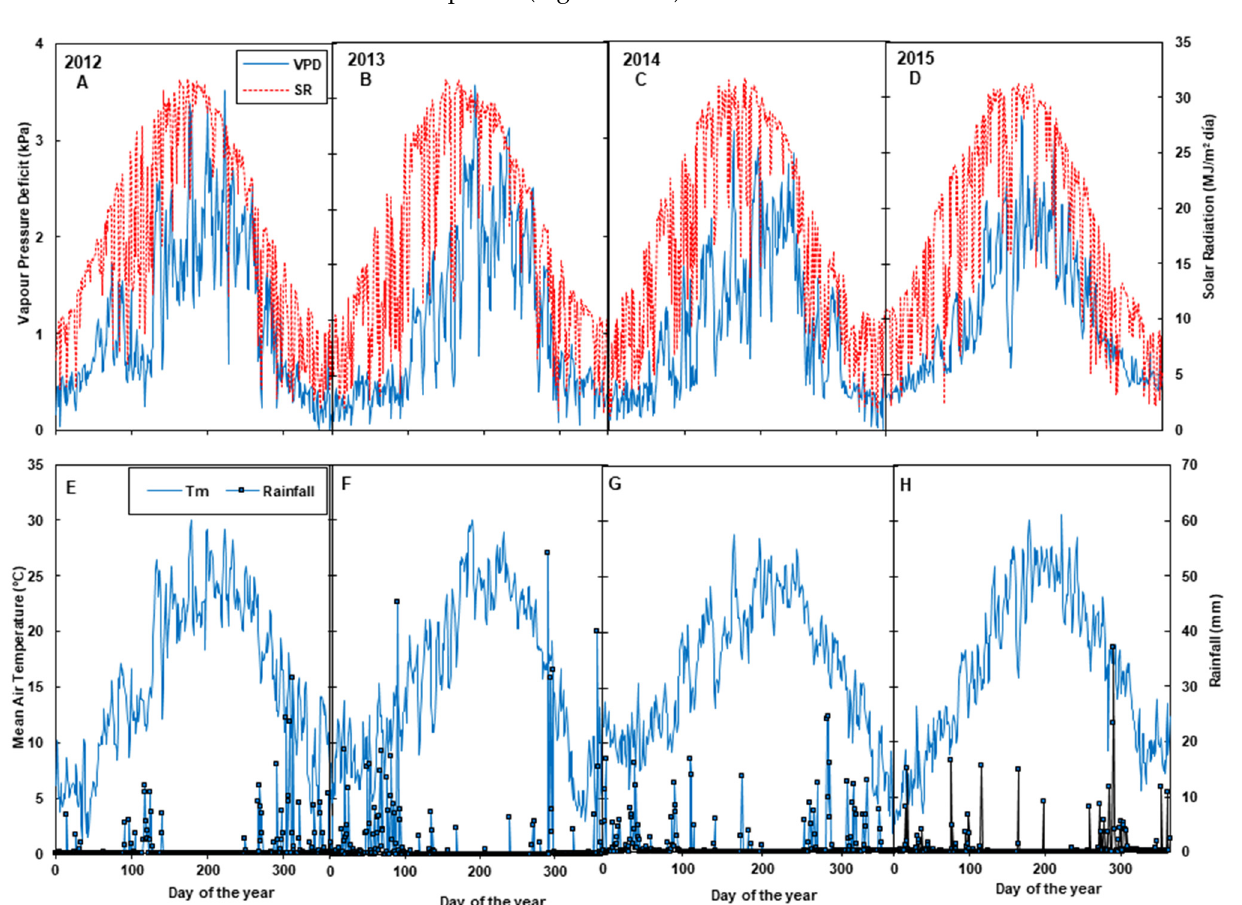
Figure 3. Annual evolution of the meteorological variables during the years of study 2012, 2013, 2014 and 2015. Mean air temperature (T m ) in °C and rainfall in mm in graphs ( E – H ). Mean solar radiation (SR) in MJ m − 2 day − 1 and mean vapor pressure deficit (VPD) in kPa day − 1 in graphs ( A – D ).